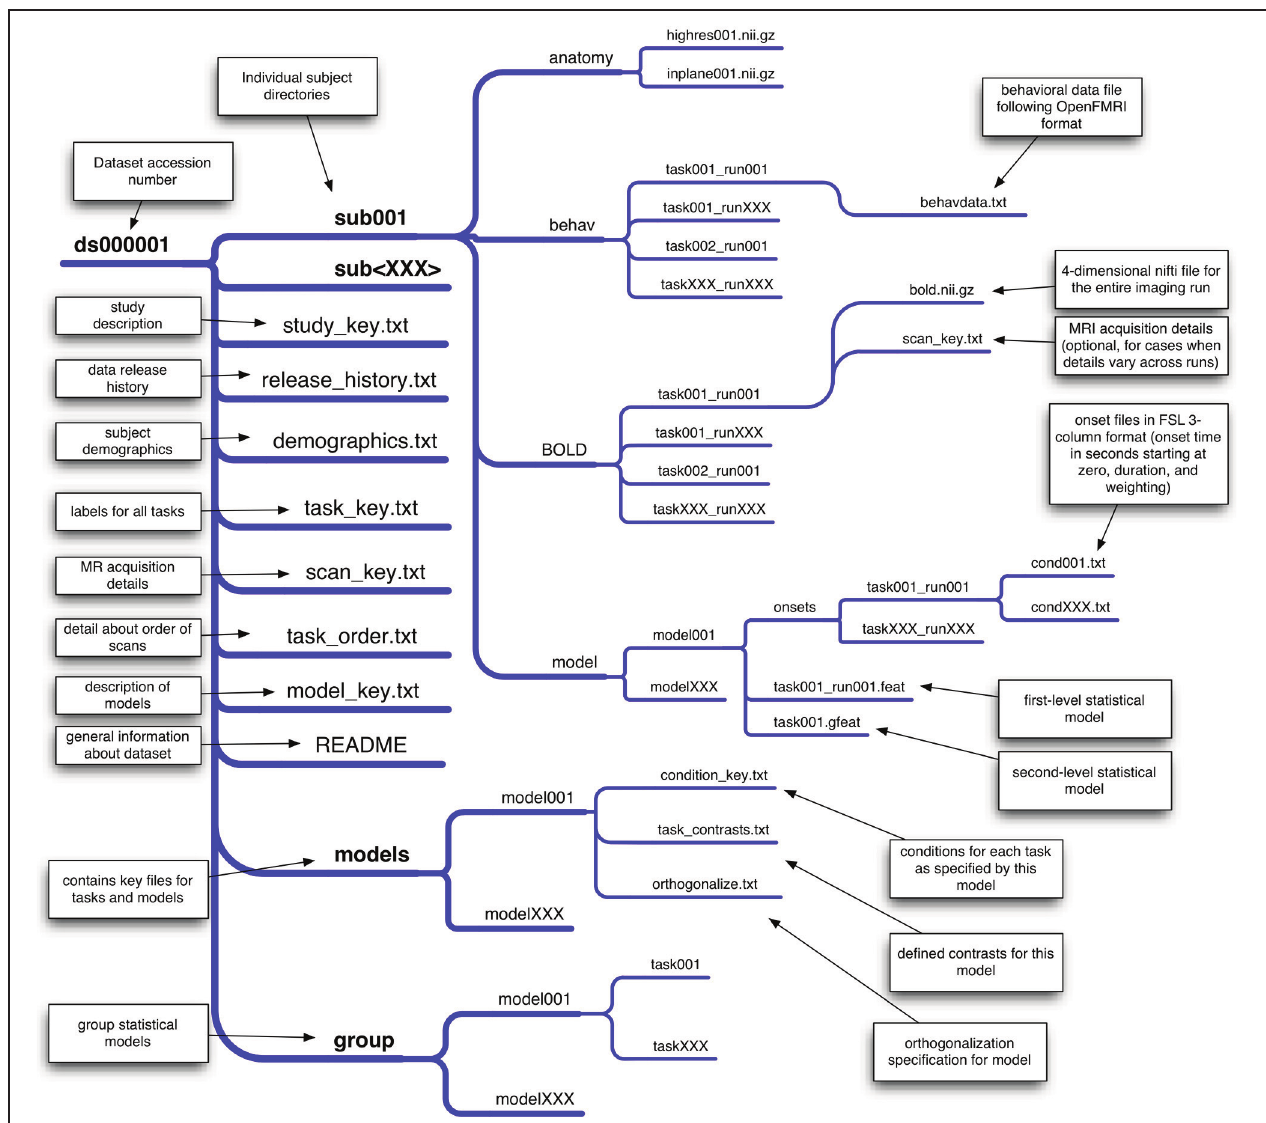
models. The key files included in the base directory for the dataset specify features that are consistent across all of the data (such as demographics, task naming, and scan ordering), while key files in subdirectories specify details that may change across models or